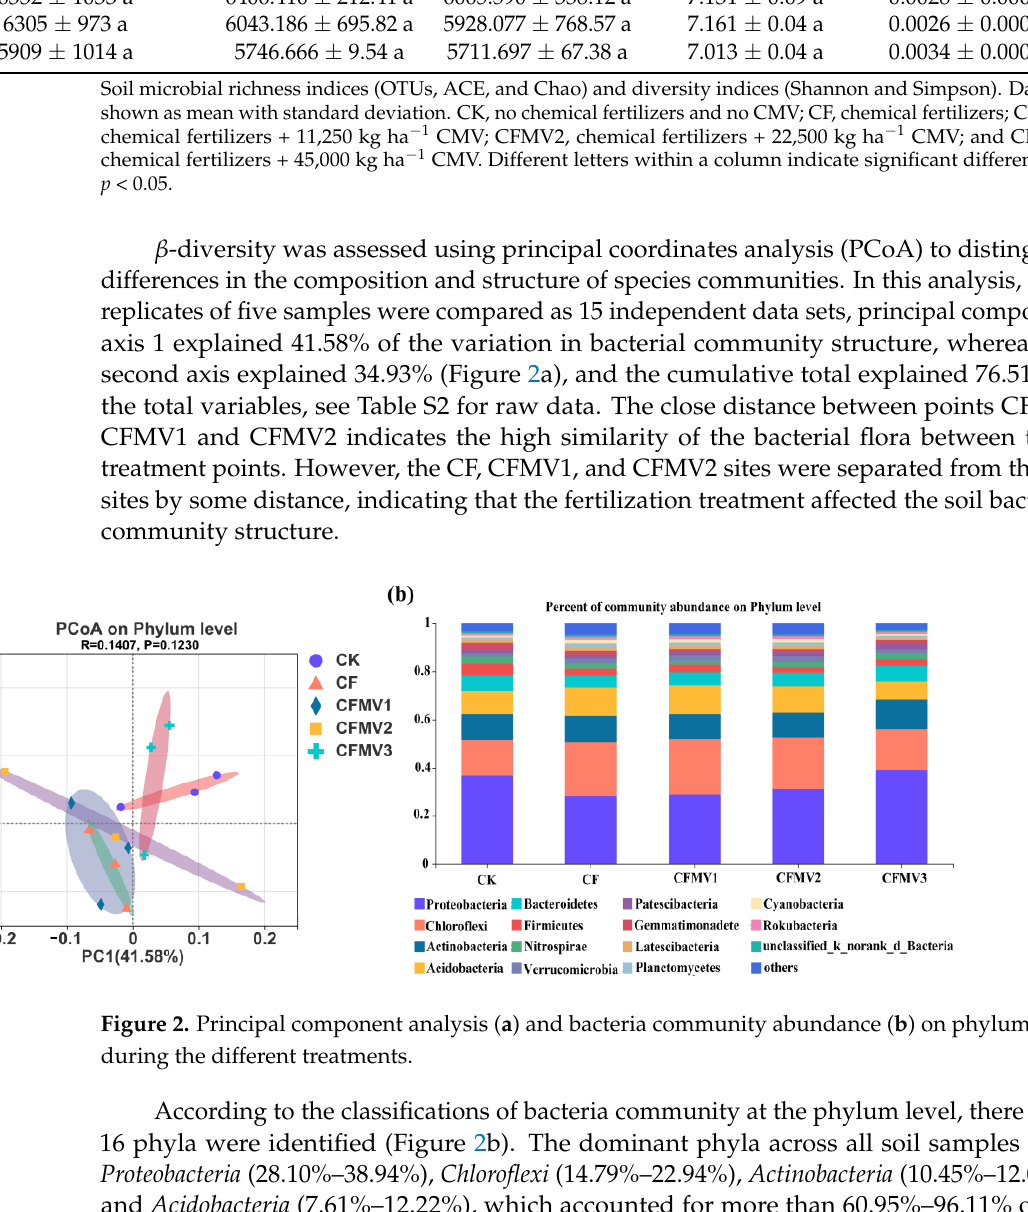
Table 2. Richness and diversity indexes of bacteria in the paddy soil treated.